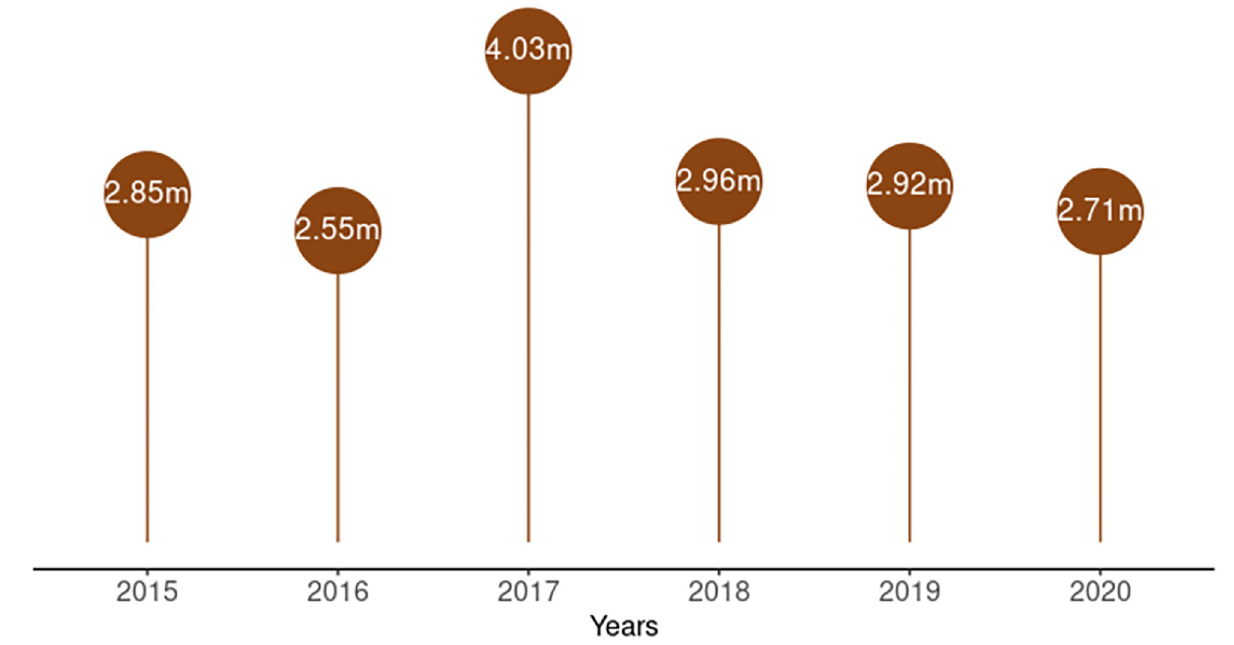
Fig 1. Lollipop chart of number of pregnant women seen at health facilities that report on PMTCT indicators from 2015–2020.